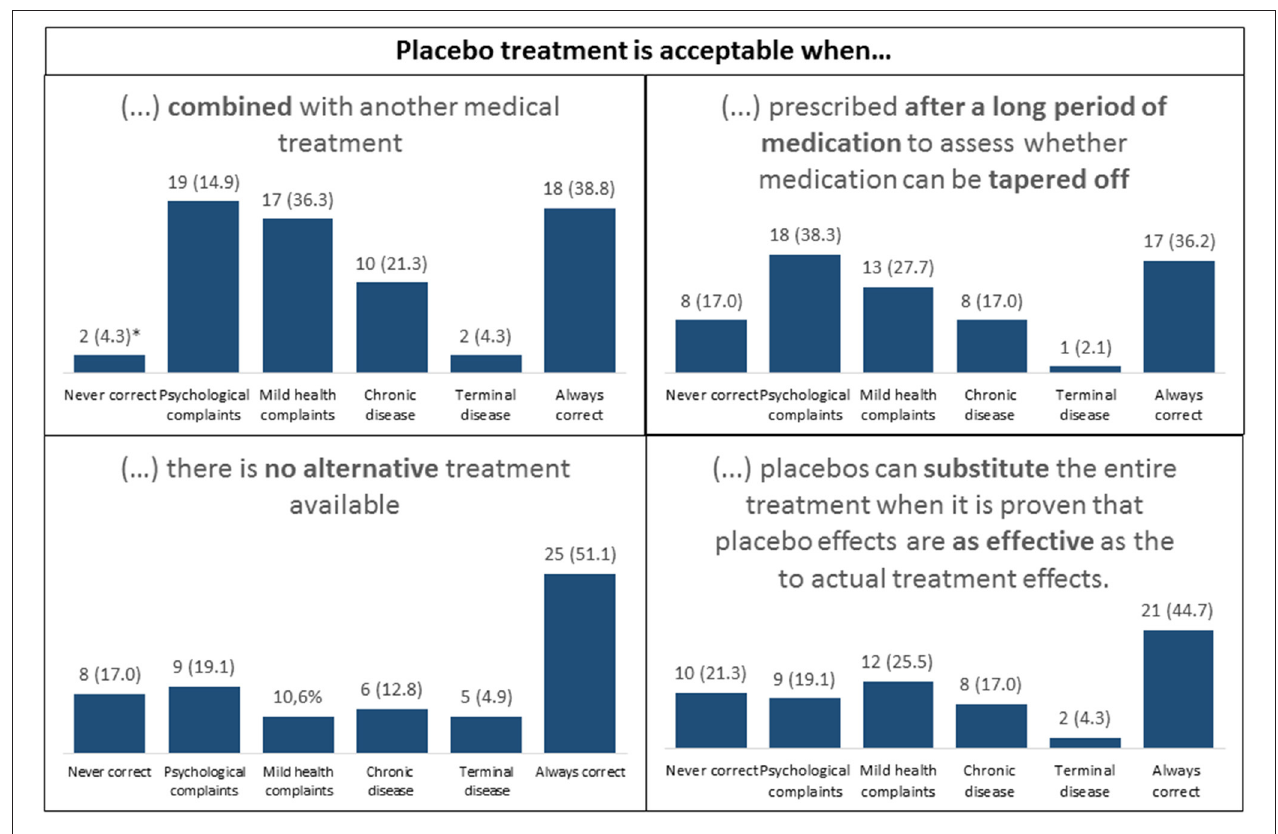
FIGURE 2 | Outcomes of placebo acceptability scores in different scenarios.* N